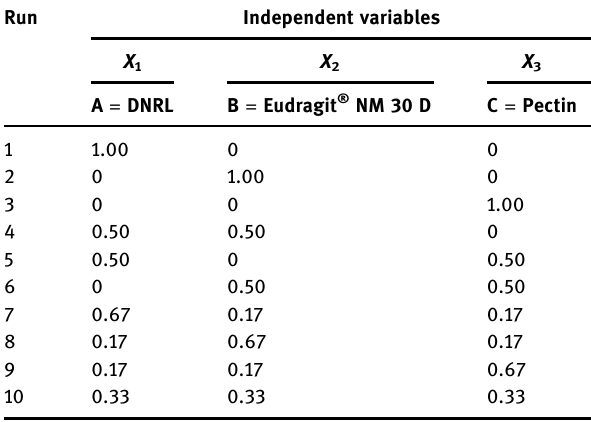
Table 1: The independent variables of the response